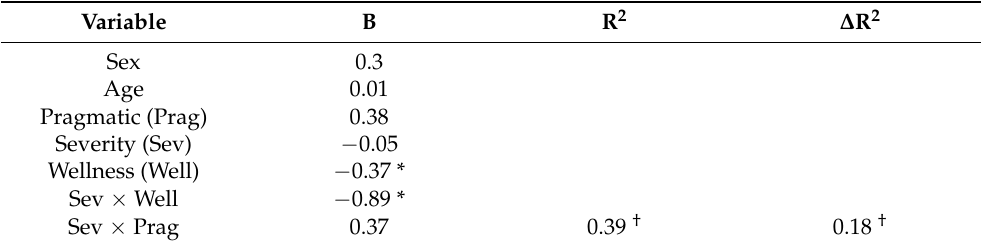
Table 2. Results of the regression analysis for overload